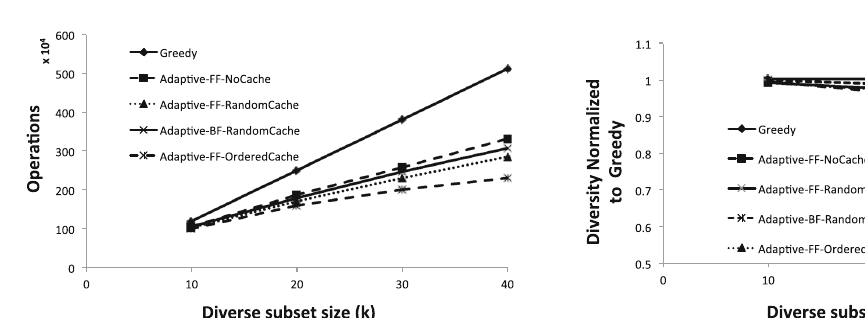
Fig. 14 Impact of ordering cache